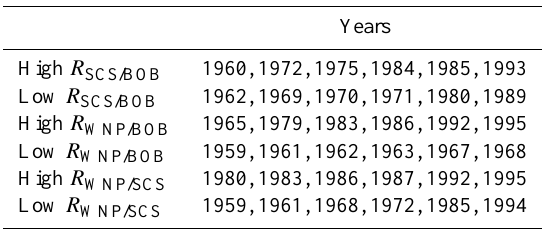
Table 3. The years of high and low R SCS/BOB , R WNP/BOB , and R WNP/SCS .